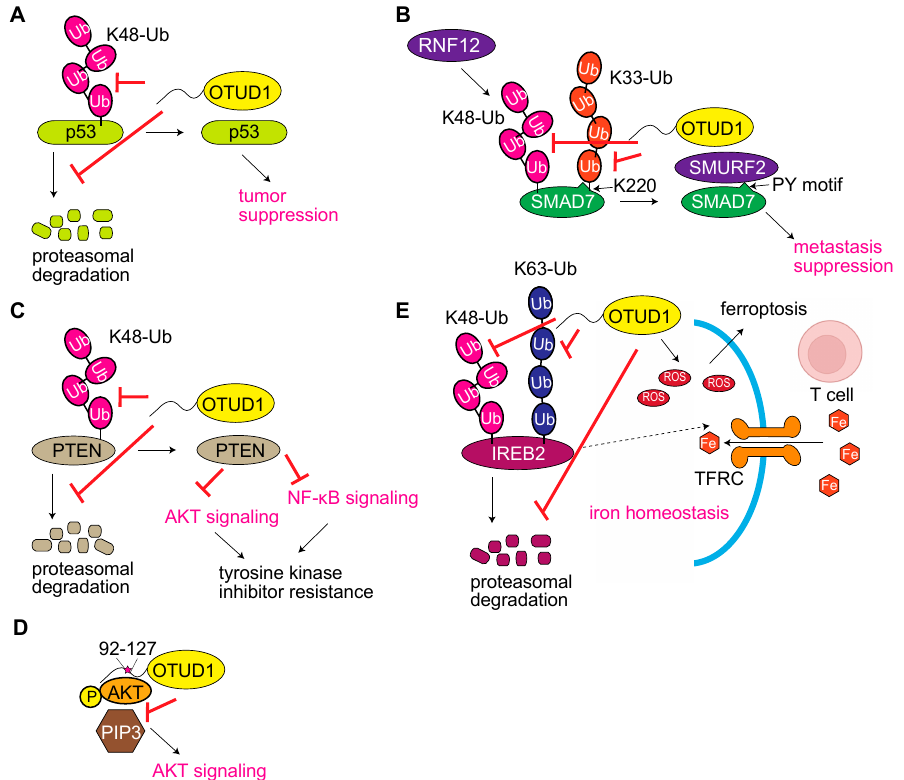
Figure 2. Effects of OTUD1 on tumorigenesis. ( A ) OTUD1 stabilizes p53 [21]. ( B ) Deubiquitination of SMAD7 by OTUD1 inhibits the TGF- β /SMAD signaling pathway and suppresses metastasis